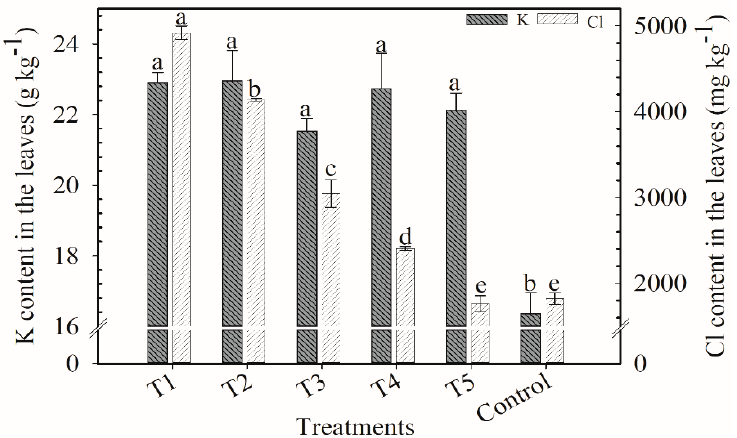
Figure 5. K and Cl content in the leaves of coffee plants. Harvest of 2019/2020. Means followed by the same letter in the column do not differ according to Tukey’s test ( p < 0.05). Vertical bars indicate the standard error of the mean ( n = 4). T1: 100% KCl; T2: 75% KCl + 25% K 2 SO 4 ; T3: 50% KCl + 50% K 2 SO 4 ; T4: 25% KCl + 75% K 2 SO 4 ; T5: 100% K 2 SO 4 ; control did not receive K 2 O.